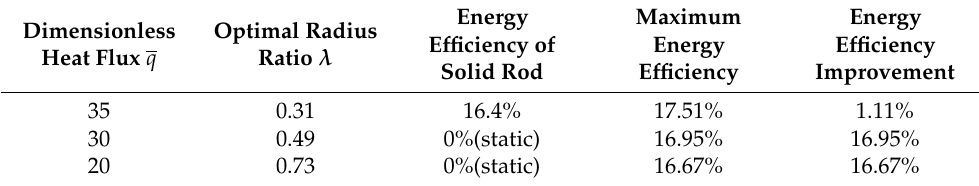
Table 3. Energy efficiency improvement of the thick-walled cylindrical